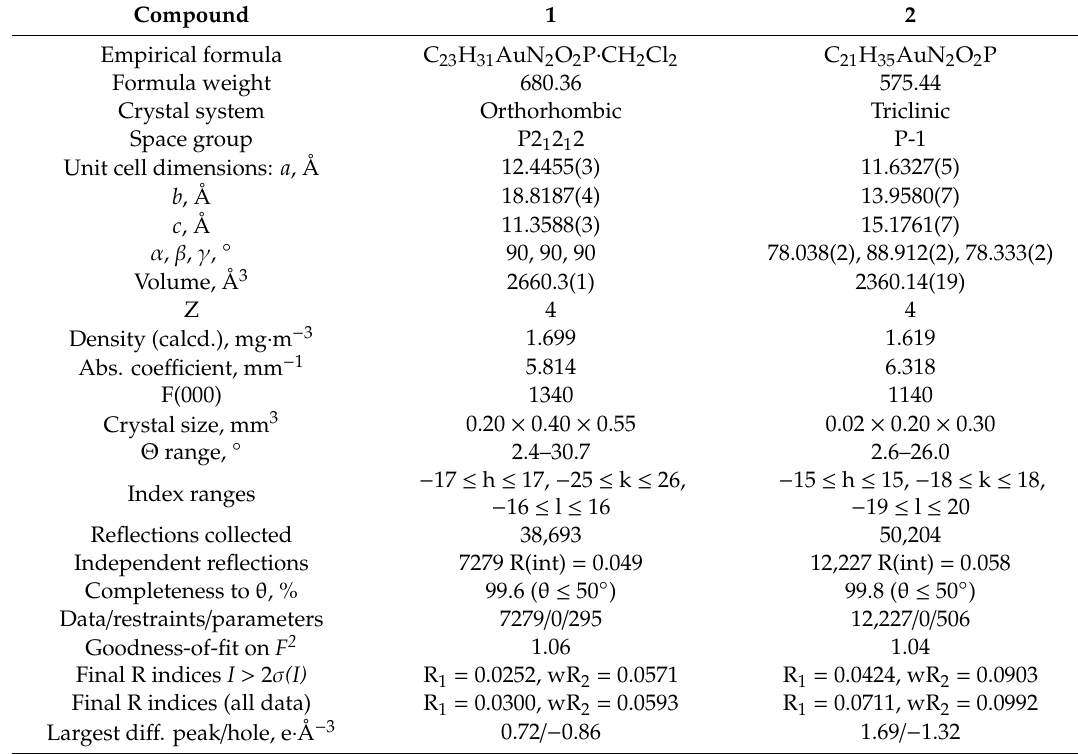
Table 1. XRD data for compounds 1 and 2